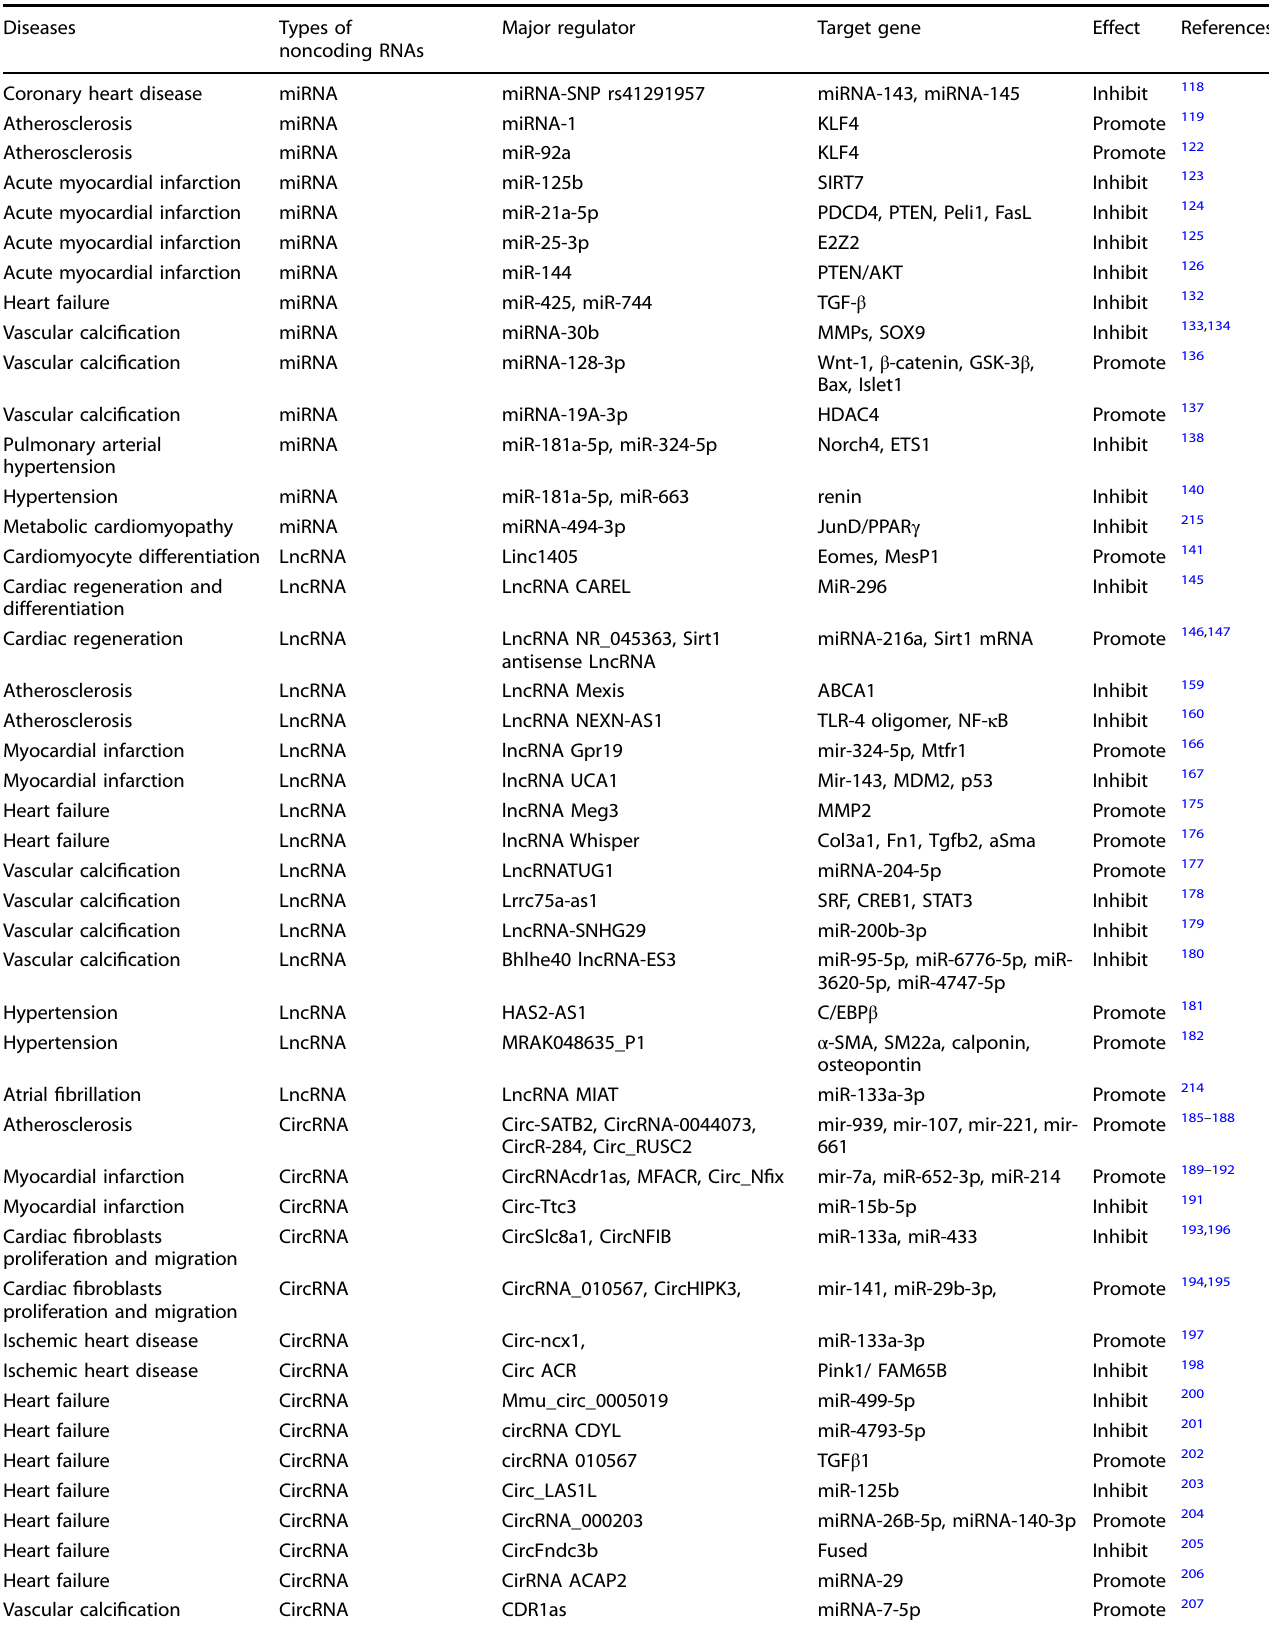
Table 4. Regulation of noncoding RNA in cardiovascular